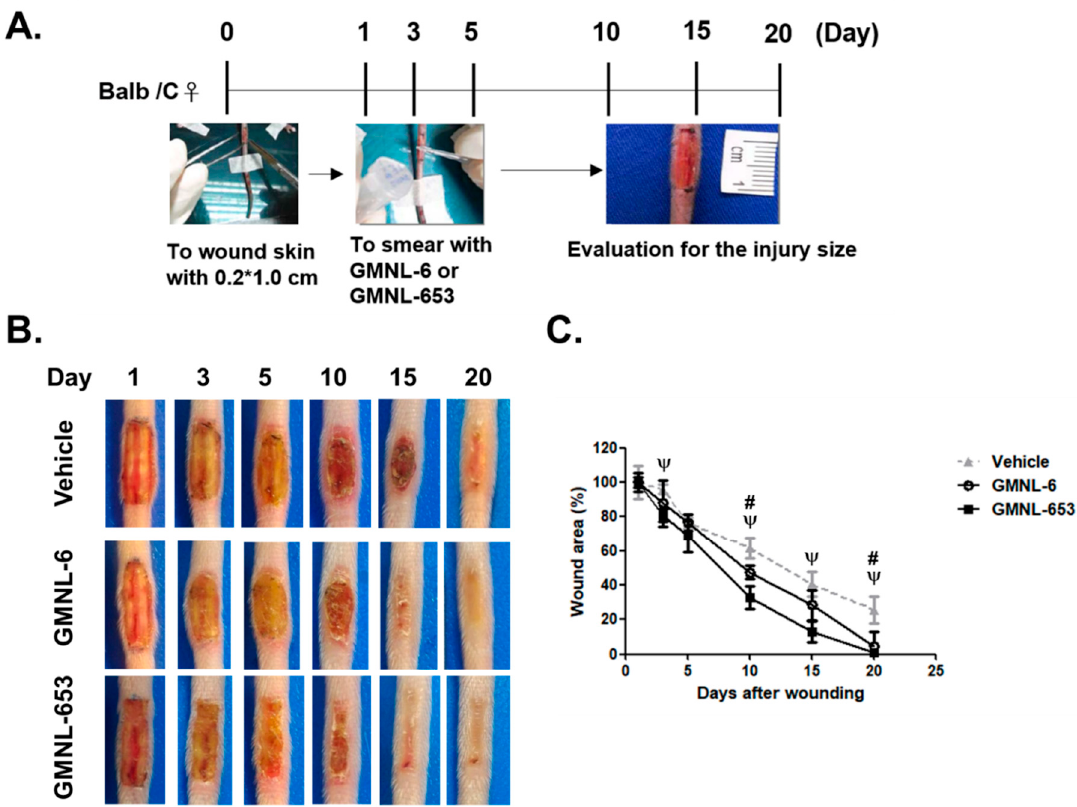
Figure 3. Heat-killed probiotics preparations of GMNL-6 or GMNL-653 exhibit excellent wound healing ability in mice. ( A ) The experimental scheme experimental skin wound of mice tails and treatment protocol using smeared gels with heat-killed GMNL-6 or GMNL-653 preparation. ( B ) The selected images of tail wounds were taken at the indicated day after wound introduction. Other images of each mouse used in this experiment were presented in Figure S1. ( C ) The quantified results of the tail wound images. For each group, n = 4; values present mean ± SEM; # or ψ presented as the p < 0.05 of GMNL-6 group or GMNL-653 group compared to the vehicle treatment group,